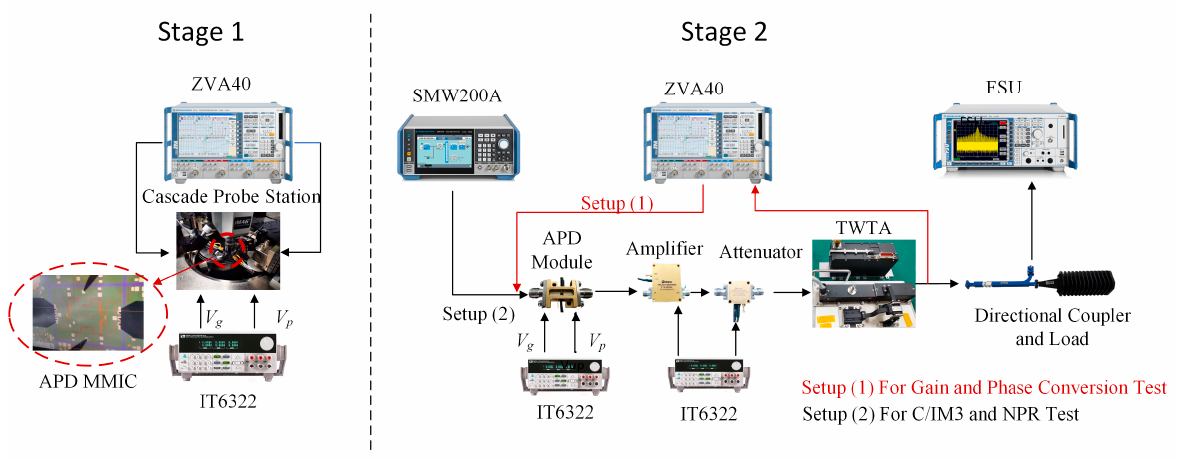
Figure 8. The test platform for APD MMIC and TWTA cascade with proposed APD